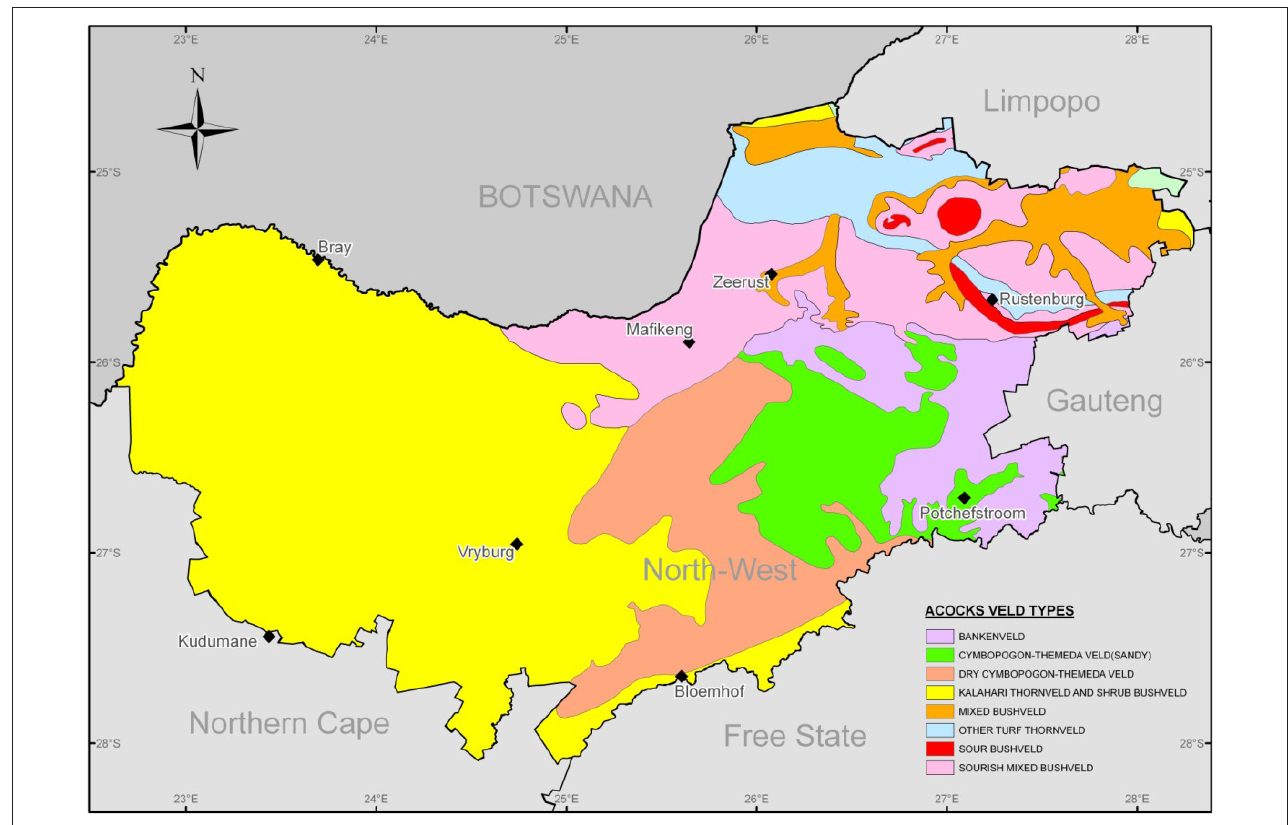
FIGURE 1: Vegetation types of the North West province of South Africa, according to Acocks, J.P.H., 1988, Veld types of South Africa with accompanying veld type map , 3rd edn., Department of Agriculture and Water Supply,